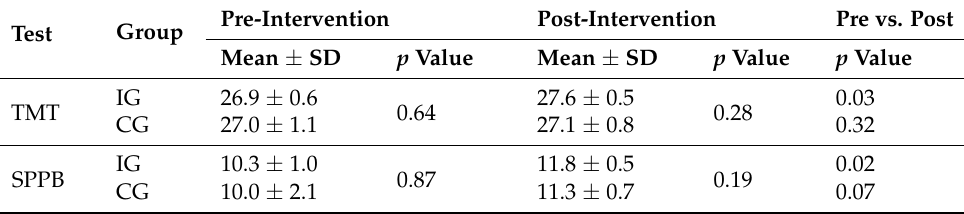
Table 2. Scores for pre- and post-intervention assessments in IG and CG.